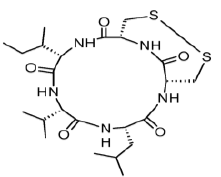
Figure 5. Structures of pseudoxylallemycins